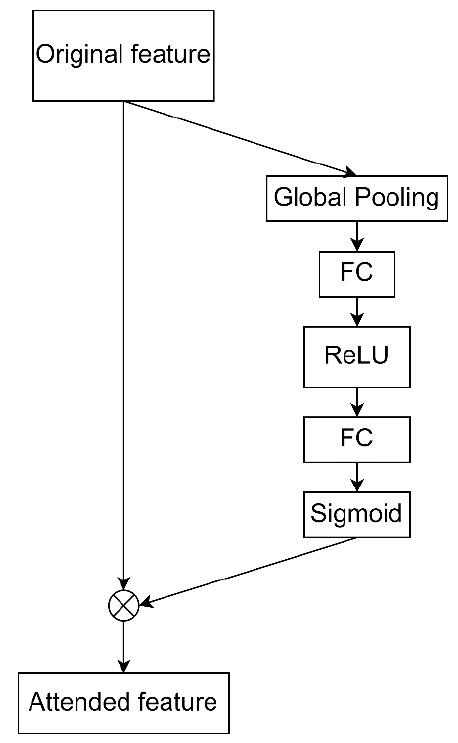
Figure 3. SE module structure diagram.